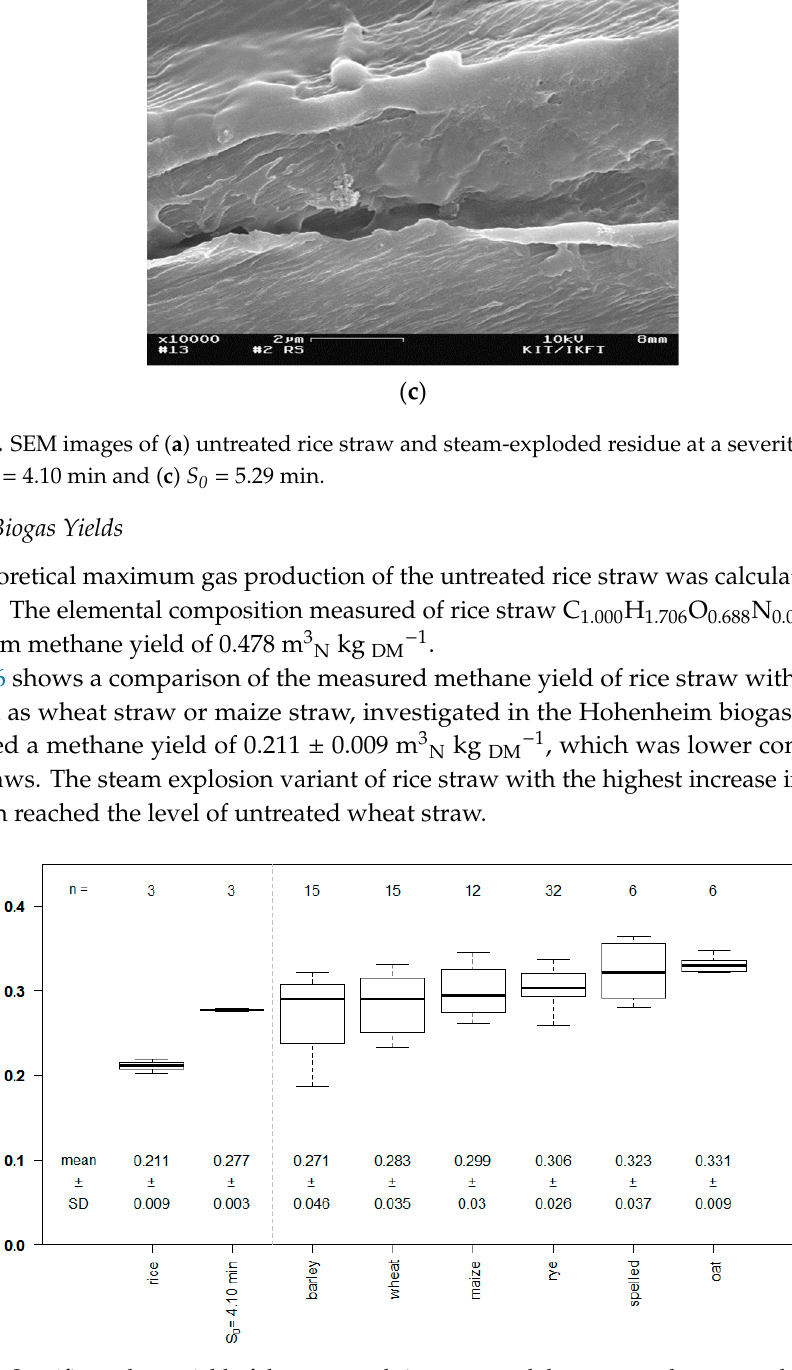
Figure 6. Specific methane yield of the untreated rice straw and the pretreated steam explosion variant S 0 = 4.10 min compared with other straws after 35 d (average yields of different samples regarding plant variety and particle size).